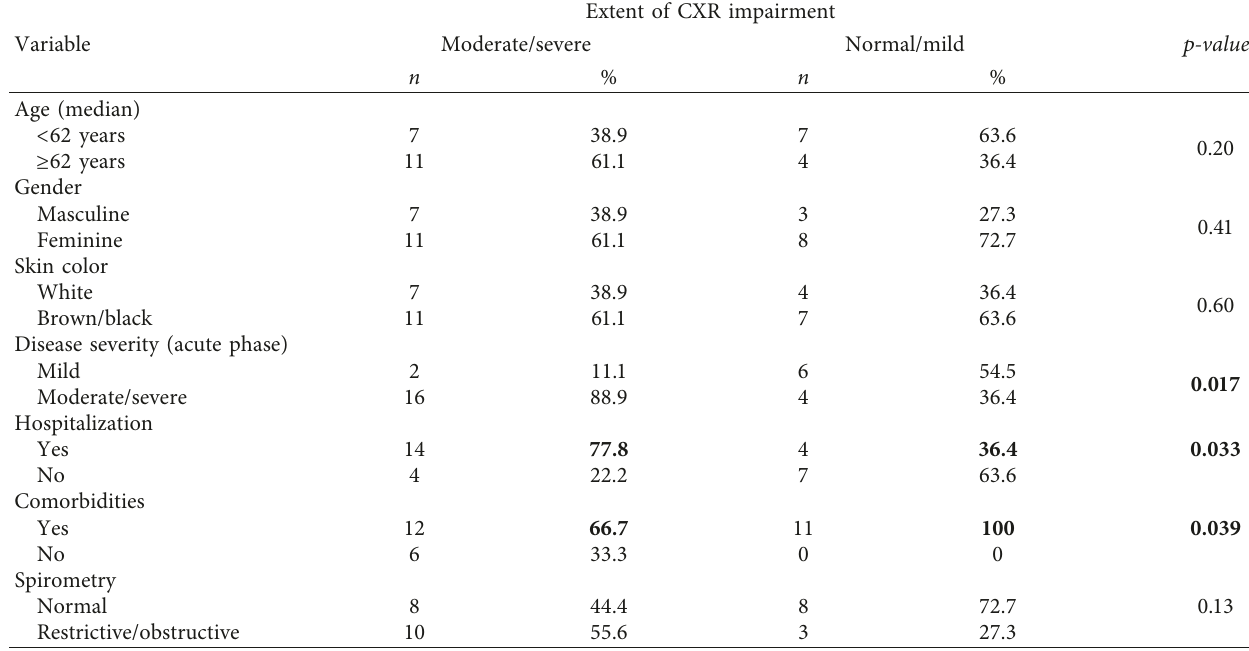
Table 2: Correlation of several variables with the extent of CXR impairment ∗